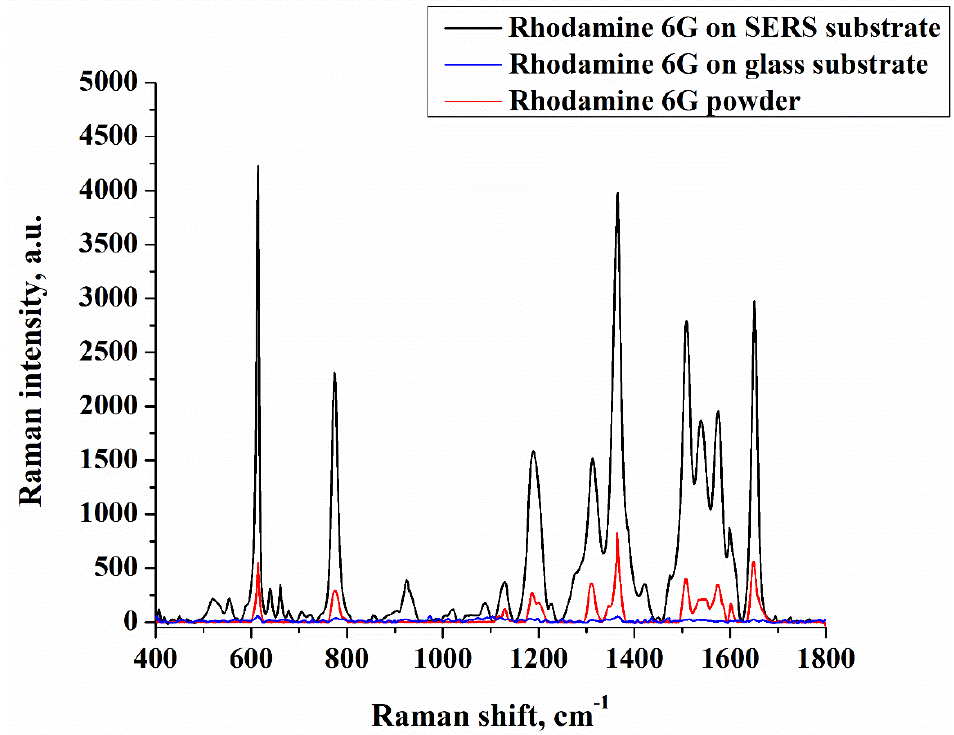
Figure 3. Raman spectra of rhodamin 6G measured on gold nanoisland SERS and pure glass substrates, and in solid form.